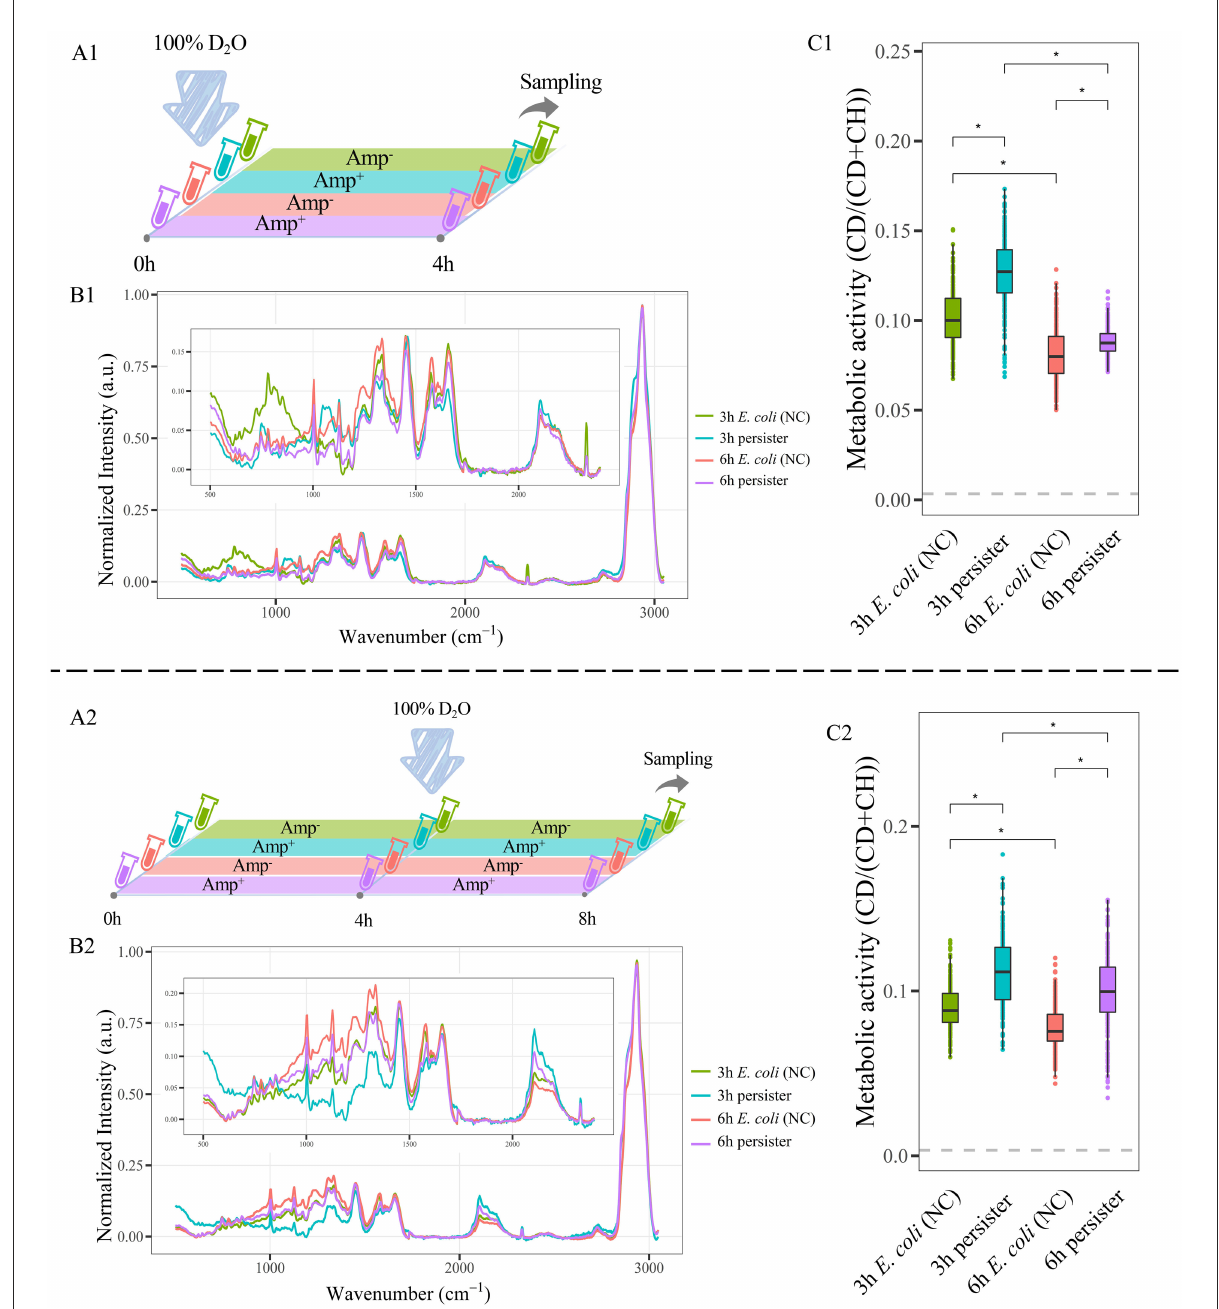
FIGURE4 C-D ratio of E. coli cells and their persisters. (A) Workflow of D 2 O labeling strategy. (A1) : E. coli cells at 3h and 6h were cultured in LB broth with 100% D 2 O and ampicillin at 100 µ g/mL for 4h. (A2) : E. coli cells obtained at 3 and 6h were treated with ampicillin (100 µ g/mL, 4h) for persister formation, followed by culture in LB broth with 100% D 2 O for another 4h (B1,B2) : The average Raman spectra of 3 and 6-h persisters and their counterpart untreated E. coli cells, normalized by the max of CH peak from 2,800 to 3,050 cm − 1 . (C1,C2) : C-D ratio of persisters and E. coli cells. N > 50 for each group. NC: E. coli cells without ampicillin treatment; * P < 0.0001.